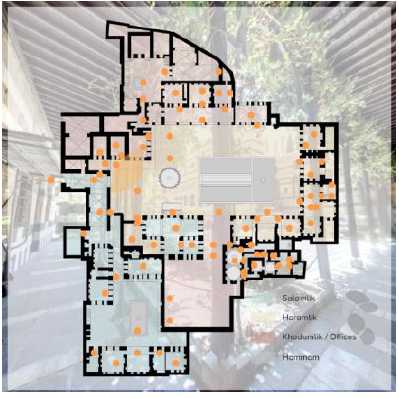
Figure 3. Al-‘Azm Palace – Interactive Map